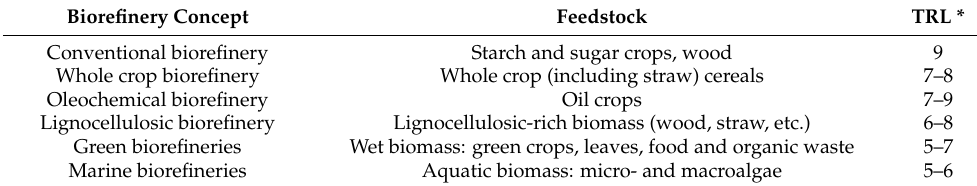
Table 2. Feedstocks and TRL of existing biorefinery